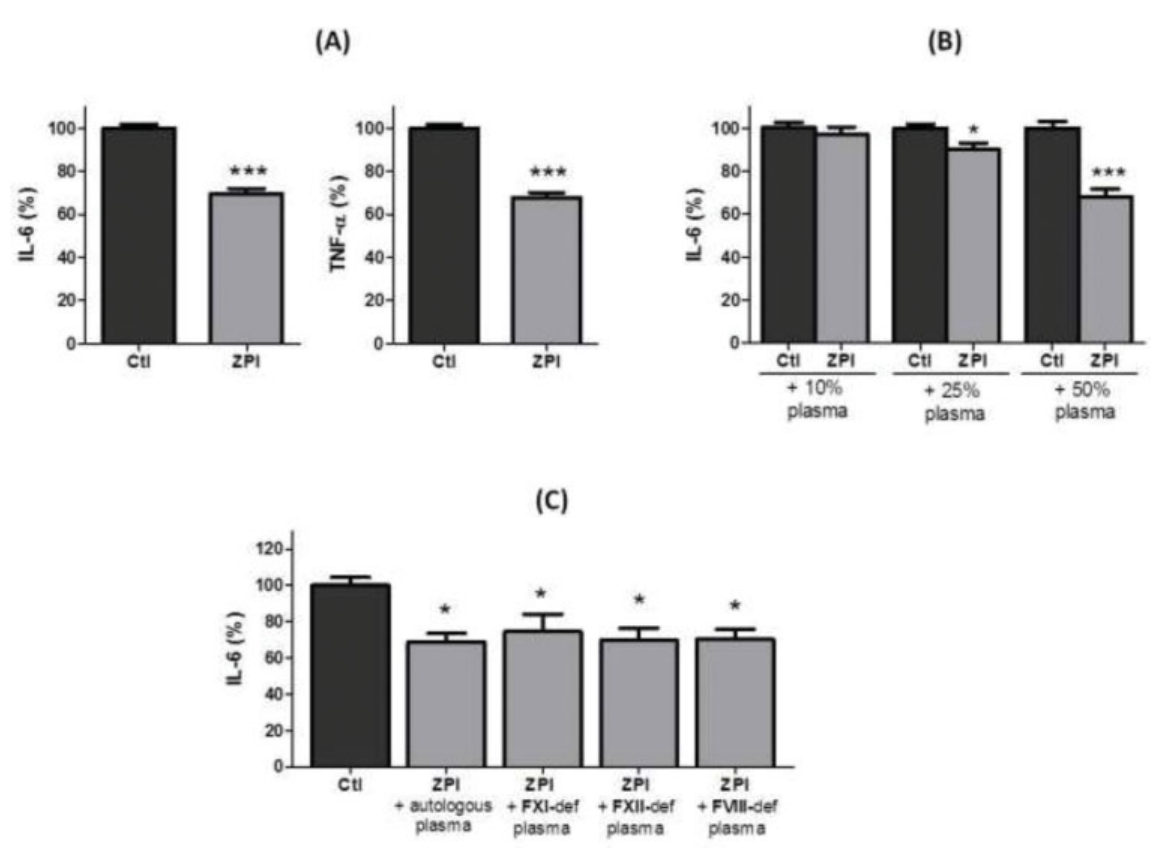
Fig. 6 Effects of cellular cooperation and plasma on the inhibitory effects of recombinant human ZPI (250 nM) on isolated lipopolysaccharide (LPS)-stimulated monocytes. rhZPI was added 30 min before the addition of 1 ng/mL of LPS. ( A ) Effects of ZPI on peripheral blood mononuclear cells. ( B ) Variations of IL-6 production by LPS-activated monocytes in the presence of ZPI (250 nM) and increasing concentrations of normal plasma. ( C ) Variations of IL-6 production by LPS activated monocytes in the presence of ZPI (250 nM) and increasing concentrations of plasmas de fi cient in coagulation factors. Results are expressed as percentages of cytokines induced by LPS which were considered arbitrarily as 100%. Results (mean (cid:4) 1 SEM) are the average of 3 independent experiments in triplicate. (cid:5) p < 0.05, (cid:5)(cid:5)(cid:5) p < 0.001 as compared to the production of cytokines in the presence of LPS alone [Student ’ s t -test ( A, B ) or Dunnett ’ s multiple comparisons test following one-way ANOVA ( C )].